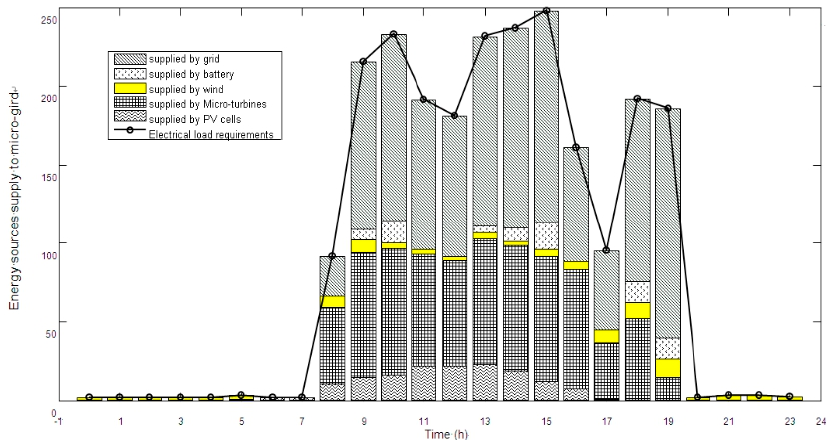
Figure 17. Composition of the electrical energy supplies.